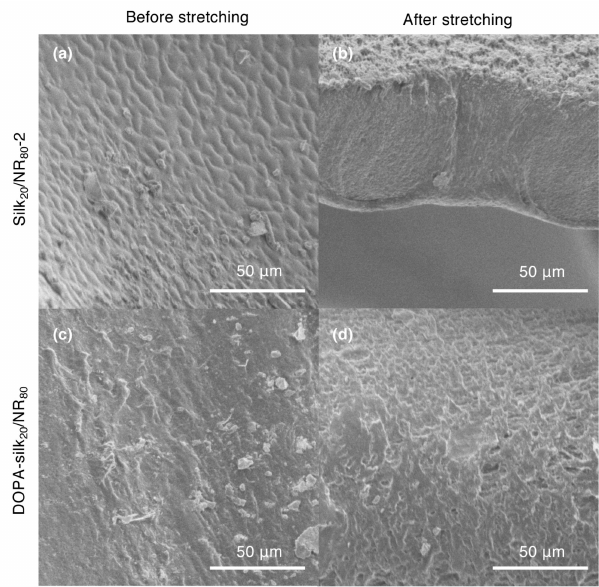
Figure 12. Cross-sectional SEM images of silk 20 / NR 80 -2 and DOPA-silk 20 / NR 80 . ( a , c ) As-prepared surface before stretching and ( b , d ) the fracture surface after